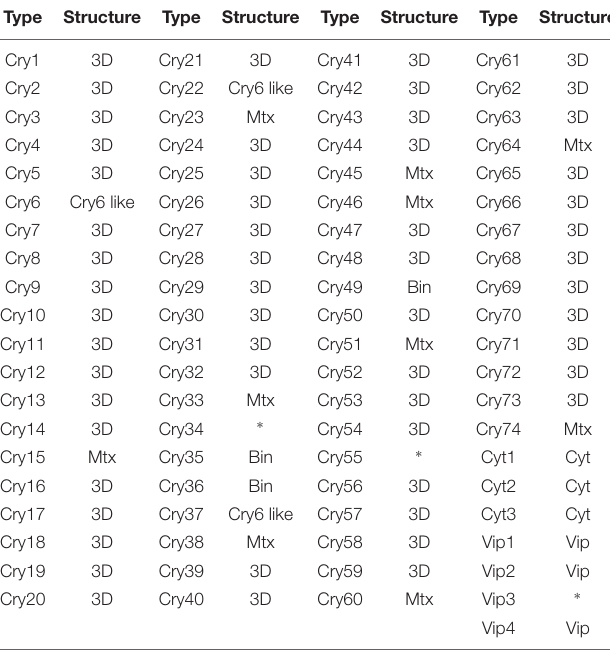
TABLE 1 | Pesticidal toxins discovered in the B. cereus – B. thuringiensis